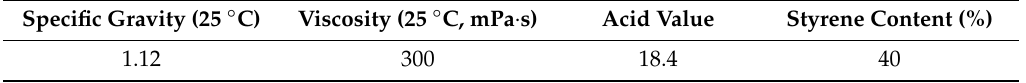
Table 1. Properties of the unsaturated polyester (UP) resin.